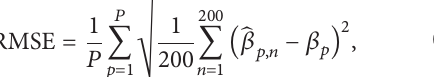
Step 3. Acquire the estimates of DODs and DOAs by search- ing 𝜃 through (19) and 𝜑 through (32),